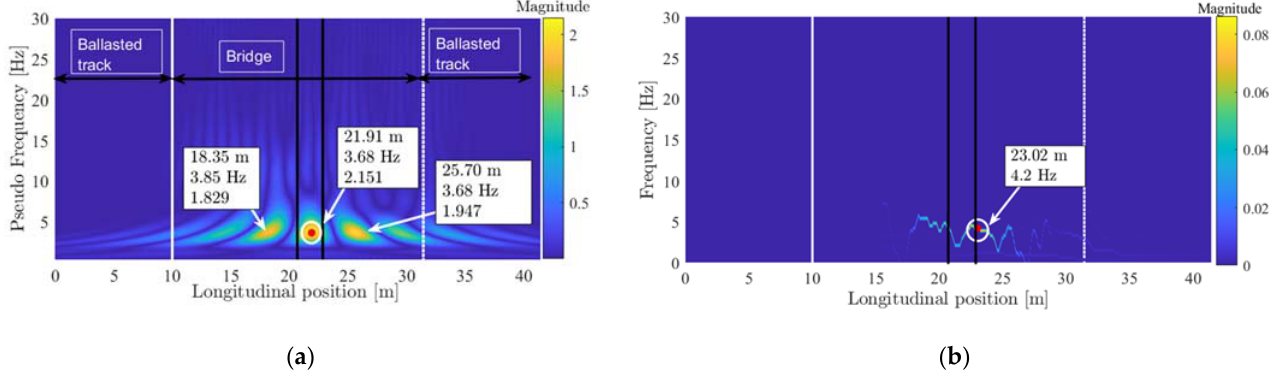
Figure 7. Leading bogie accelerations corresponding to the healthy and the damaged bridge. The CSA train travelling at 100 km/h, in the absence of irregularity and total damage affecting the side wall diagonal chord.